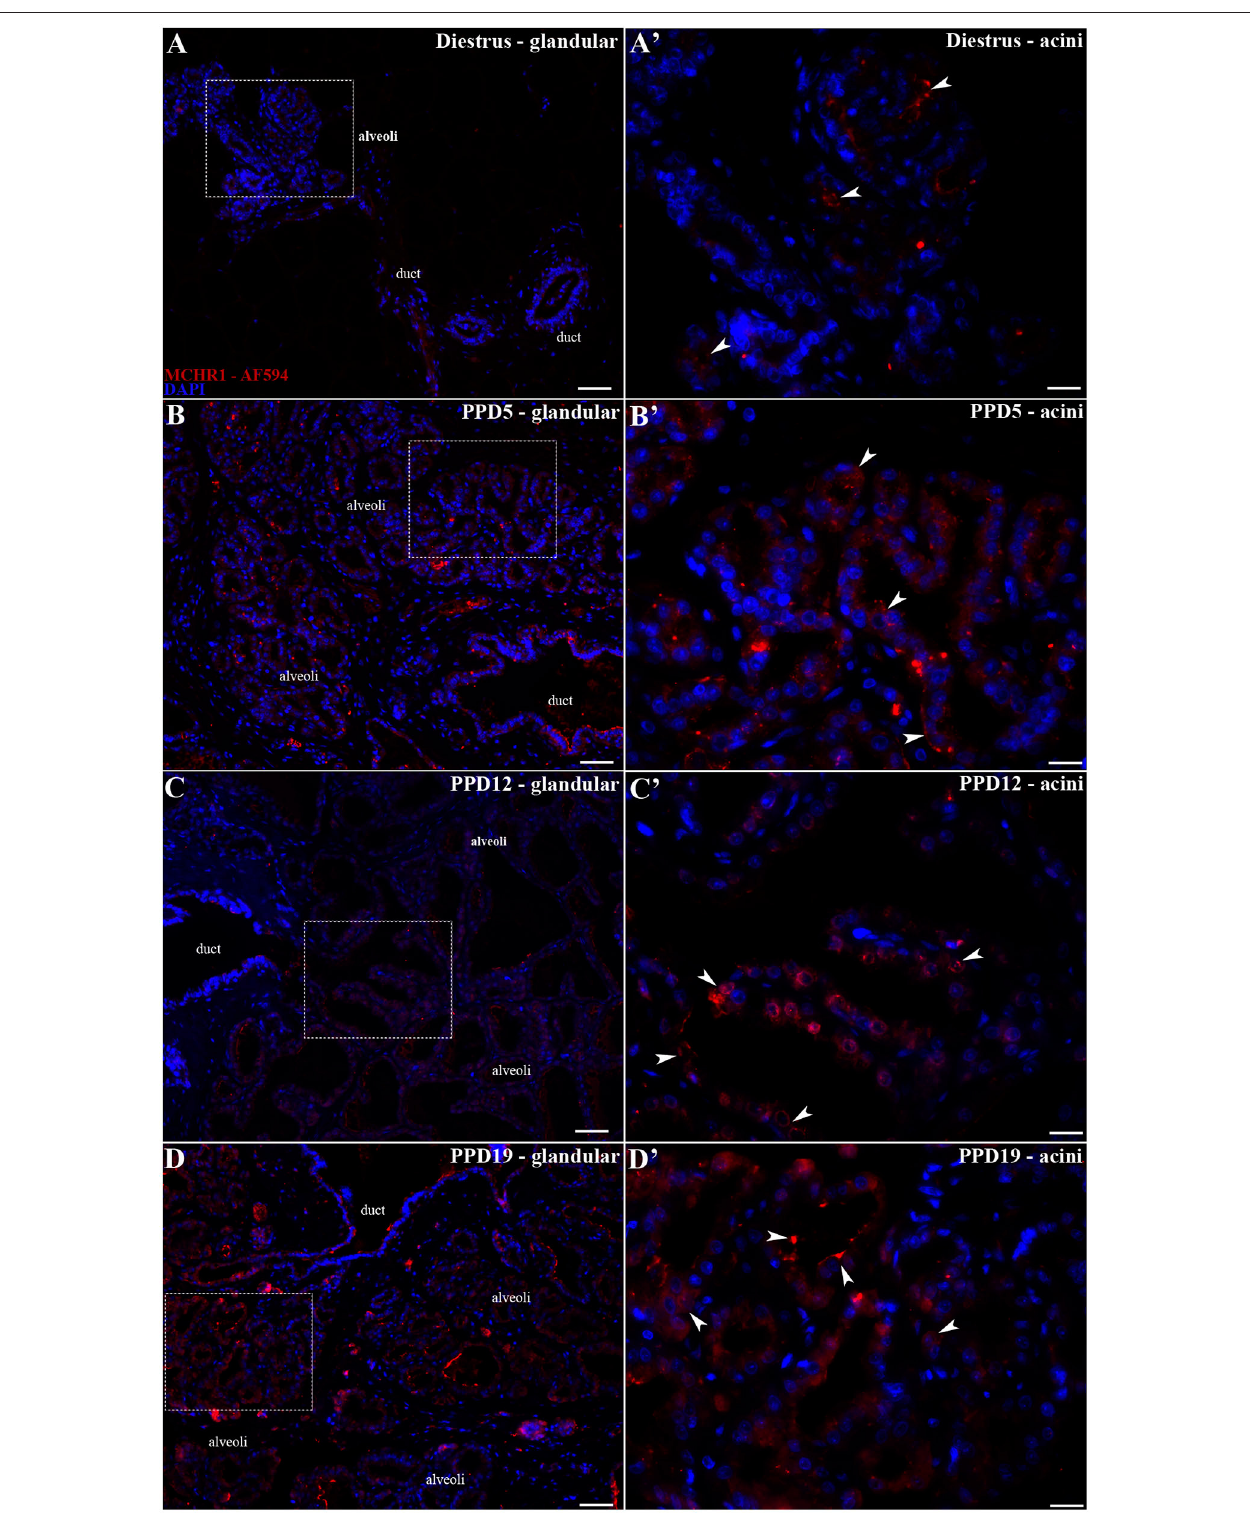
FIGURE 4 | MCHR1 immunoreactivity in the rat mammary gland. Wide field fluorescence photomicrographs of sagittal mammary gland slices from diestrus and lactating rats ( n = 3/group) submitted to indirect immunofluorescence for MCHR1 (red) and counterstained with DAPI nuclear stain (blue). (A) The mammary gland